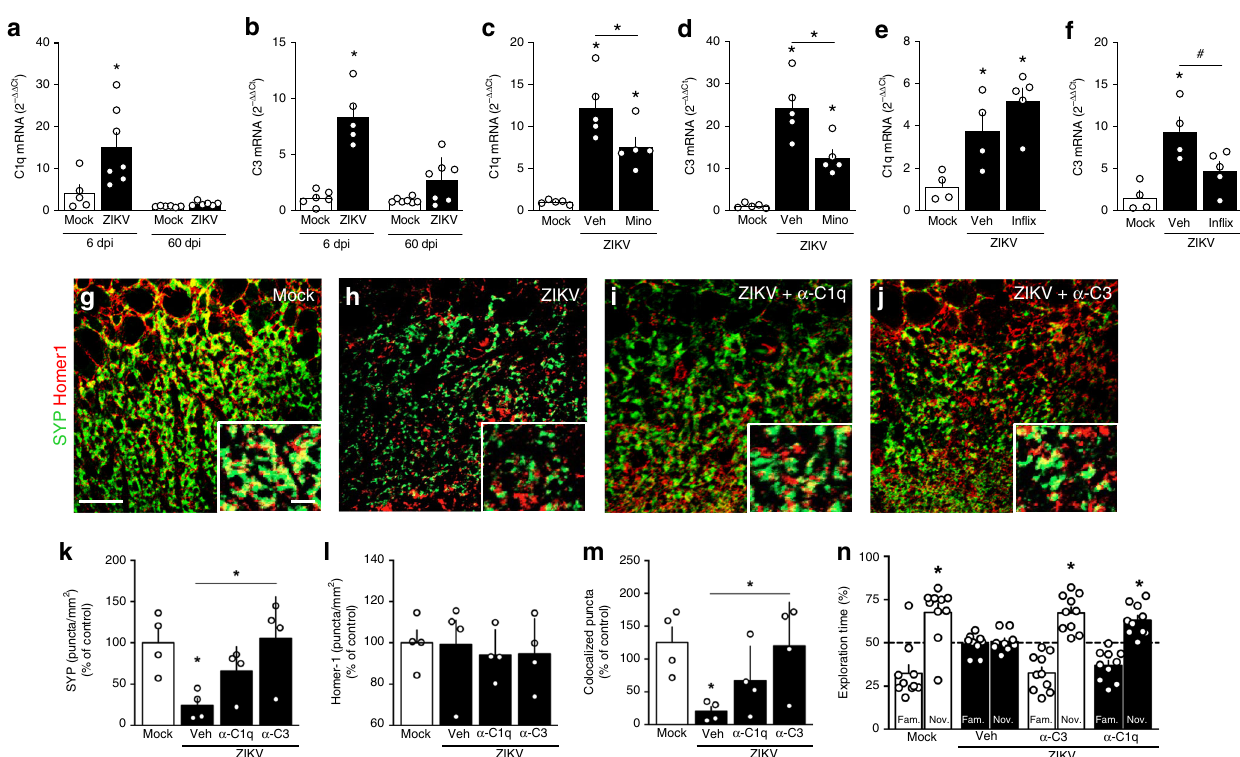
Fig. 7 Role of complement system in ZIKV-induced memory impairment. a , b Adult mice received an 10 5 PFU ZIKV (i.c.v.) or mock medium. At 6 or 60 dpi, brain expression of C1q ( a F(3,22) = 11.63, * p = 0.003; one-way ANOVA followed by Bonferroni ’ s) and C3 ( b F(3,21) = 26.92, * p < 0.0001; one-way ANOVA followed by Bonferroni ’ s) were measured. N = 6 (6 dpi, mock), 5 (6 dpi, ZIKV), and 7 (60 dpi, both groups). c – f Mock-infused and ZIKV-infected mice were treated with minocycline ( c , d Mino; 50 mg/kg i.p., 3 times/week beginning 1 week prior to infection) or In fl iximab ( e , f In fl ix; 0.2 μ g/day, from 2 to 6 dpi, i.c.v.). At 6 dpi, brain expression of C1q ( c F(2,12) = 22.84; * p < 0.0001 mock vs. ZIKV; * p = 0.0054 mock vs. ZIKV + Mino; * p = 0.0388 ZIKV vs. ZIKV + Mino; N = 5 mice/group. e F(1,10) = 10.49; * p = 0.038 ZIKV; * p = 0.0021 ZIKV + In fl ix, one-way ANOVA followed by Bonferroni, N = 4 (mock and ZIKV + veh) and 5 (ZIKV + In fl ix)) and C3 ( d : F(2,12) = 29.63, * p < 0.0001 mock vs. ZIKV, * p = 0.0075 mock vs. ZIKV + Mino; * p = 0.0064 ZIKV vs. ZIKV + Mino; N = 5 mice/group. f: F(2,10) = 9.464, * p = 0.0045 mock vs. ZIKV, # p = 0.0674 ZIKV vs. ZIKV + In fl ix; one-way ANOVA followed by Bonferroni, N = 4 (mock and ZIKV + veh) and 5 (ZIKV + In fl ix)). g – m Mock-infused and ZIKV-infected mice treated with PBS or 0.15 μ g antibodies against C3 or C1q at 4 or 5 dpi. g – j Representative images of the CA3 hippocampal region of mock-infused ( g ), ZIKV + veh ( h ), ZIKV + anti-C1q antibody ( i ), and ZIKV + anti-C3 antibody mice ( j ) immunolabeled for synaptophysin (SYP, green) and Homer1 (red). Scale bar = 25 μ m, inset scale bar = 5 μ m. k – m Puncta for SYP ( k ), Homer1 ( l ) and colocalized SYP/PSD-95 ( m ). ( k F(3,12) = 4.514, * p = 0.031 mock vs. ZIKV, p = 0.0205 ZIKV vs. ZIKV/ α -C3. m F(3,12) = 4.077, * p = 0.0317 mock vs. ZIKV, p = 0.0412 ZIKV vs. ZIKV/ α -C3, one-way ANOVA followed by Bonferroni, N = 4 mice/group). n Mock-infused and ZIKV-infected mice treated with anti-C3, anti-C1q (0.30 μ g, i.c.v.) or vehicle (PBS). At 6 dpi, mice were tested in the NOR test (t = 3.527 * p = 0.0064 Mock + veh, t = (other groups). Bars represent means± SEM. Symbols represent individual mice. Source data from panel a – f and k – n are provided as Source Data